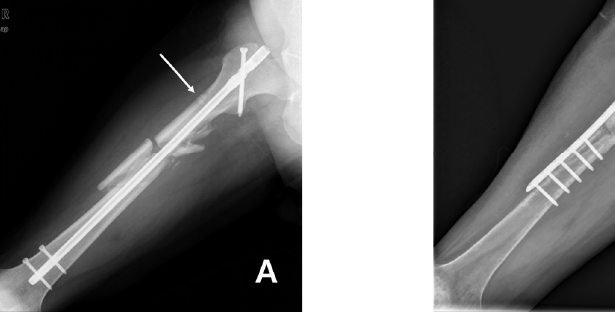
Figure 4. Serial conventional radiography from the first operation to the time of the discovery of the fracture. ( A ) The traces of the Steinmann pin insertion visible after the first operation; ( B ) Six months later, after internal device replacement surgery, trace is visible between the screws; ( C ) The trace remained even after 5 years from first surgery (white arrow).